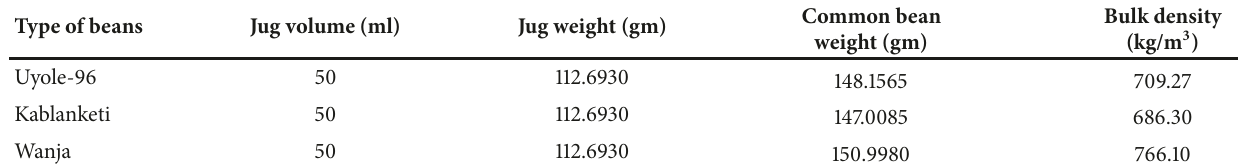
Table 8: Common beans bulk density results.